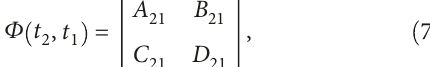
planar short periodic orbit ( amplitude = 4,000km ); (d) L 4